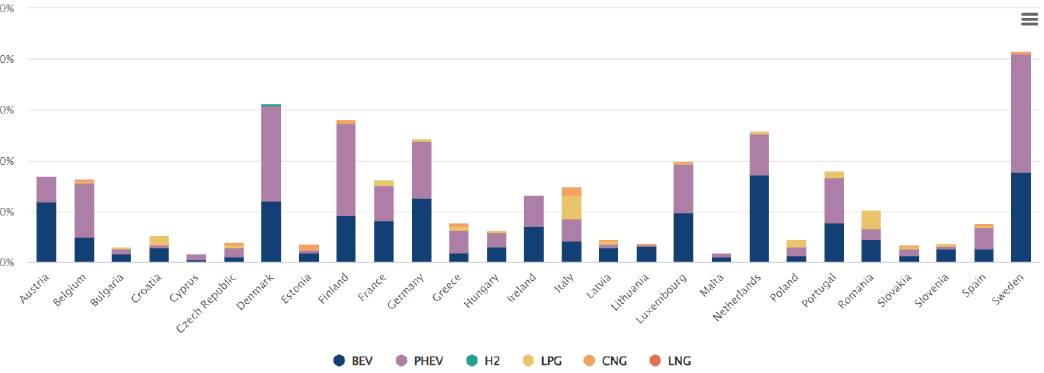
Figure 2. Alternative Fuel passenger cars and vans (BEV, PHEV, H2, LPG, CNG, LNG) as % of new registrations in the EU-27 during 2021; from [1].